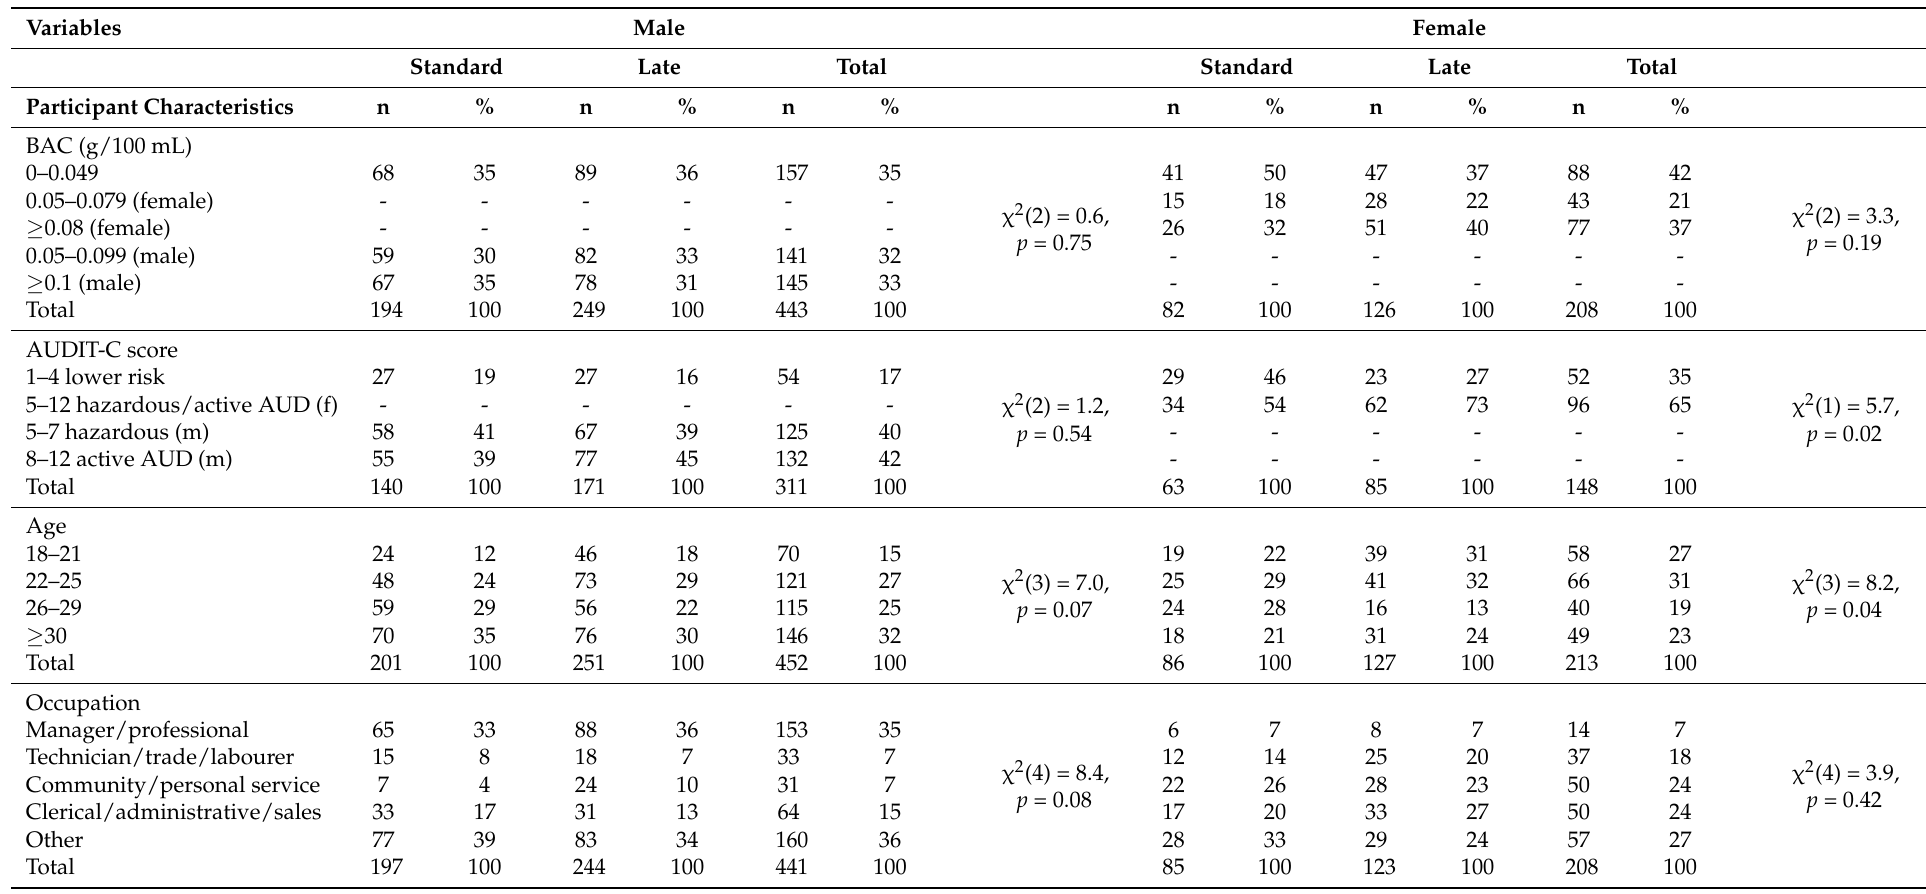
Table 1. Gender-specific descriptive statistics and bivariate analyses for participant and survey characteristics by preferred bar type (standard vs.